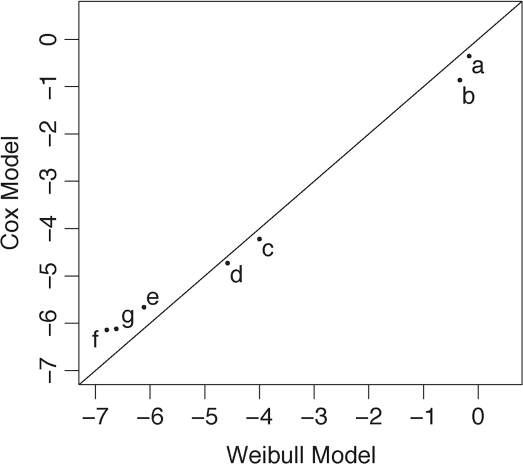
Comparison of mathematical models derived from serial dilution data.Calculations of log reduction upon inactivation treatment, using the Weibull (abscissa) and Cox (ordinate) models, produce similar results. Serial dilutions of 301V-infected brain homogenate were modeled using the Cox and Weibull regression methods and log reduction was calculated for each treatment by both methods. Samples were treated as follows: ddH2O, 65°C, 18 h (a); 1% AcOH, 65°C, 18 h (b); 4% SDS, 65°C, 18 h (c); 4% SDS–1% AcOH at 65°C for 30 min (d), 2 h (e), and 18 h (f); autoclaved at 134°C for 15 min (g). The correlation coefficient to the line of identity is 0.99.